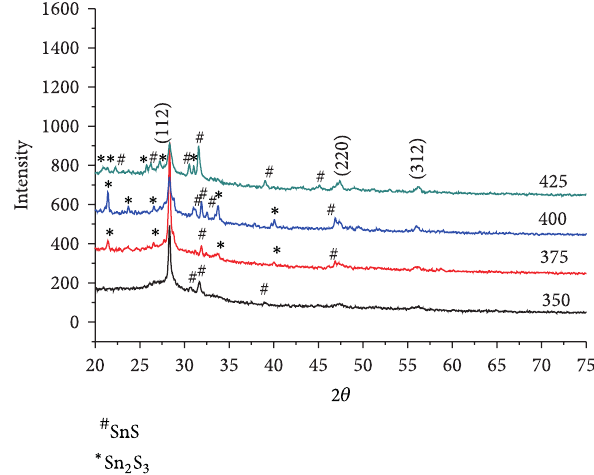
Table 1: Sample names of the CTS thin films with different sulfurization conditions.